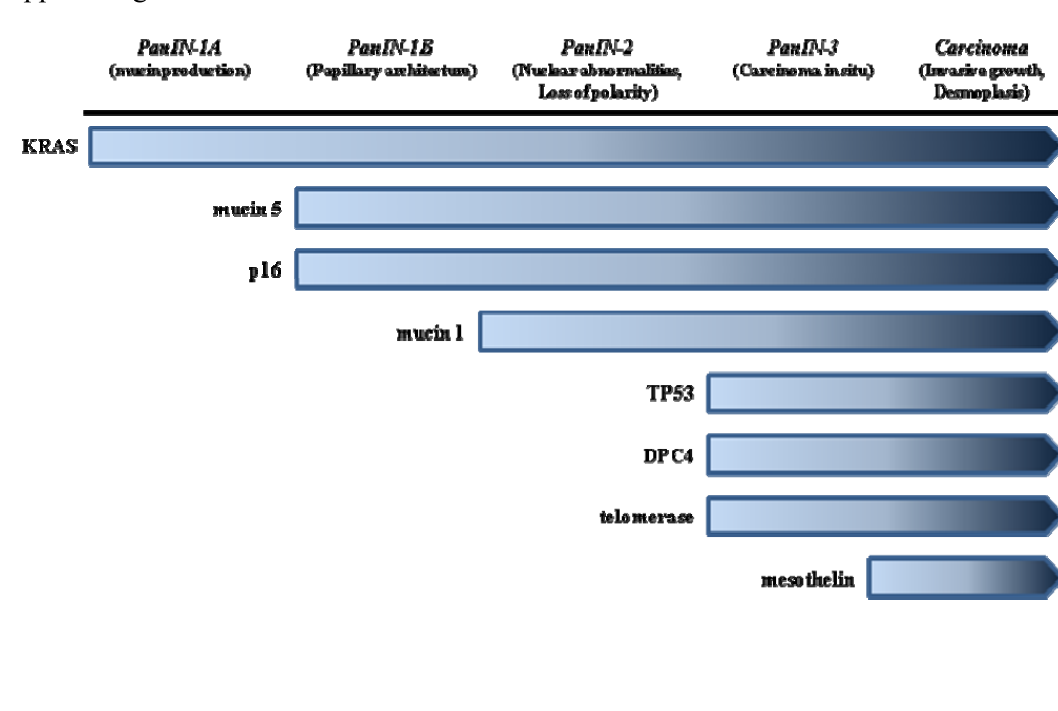
Figure 1. Precursor lesions in PDAC: correlation with oncogenes and tumor suppressor